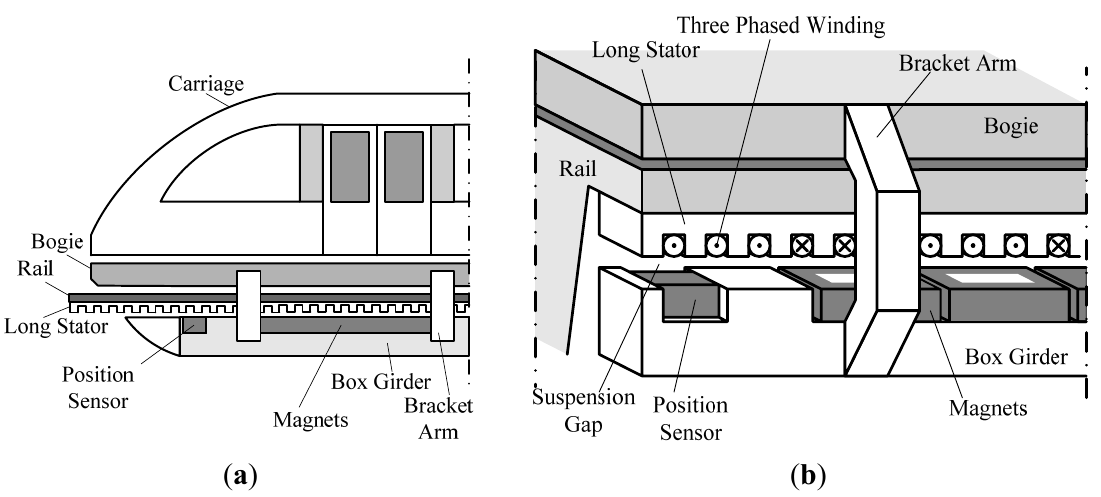
Figure 1. ( a ) Diagram of a high speed maglev train; ( b ) Diagram of the substructure of a high speed maglev train.